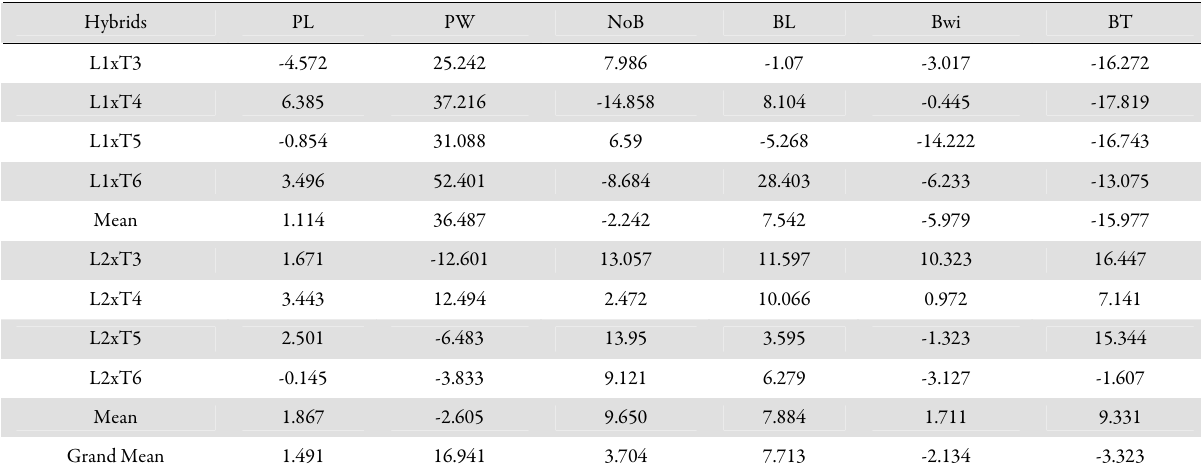
Tab. 7. Mid-parent heterotic performance of the eight hybrids for the six traits